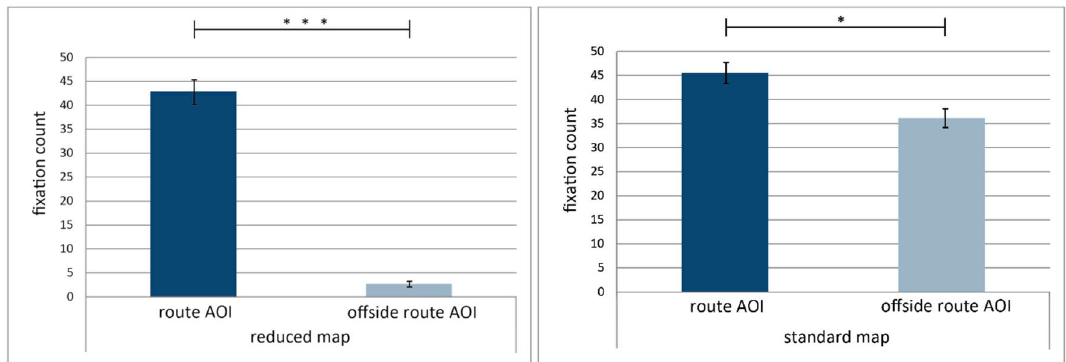
Figure 4. Fixation count differences between the route AOI and the offside route AOI for both map conditions. In both map conditions, fixation counts on the route AOI were significantly higher than fixation counts on the AOI offside the route. In the reduced maps (M RouteAOI = 42.867, M OffsideRouteAOI = 2.724, W = 1, p < 0.001), the difference was larger than in the standard maps (M RouteAOI = 45.506, M OffsideRouteAOI = 36.136, W = 88, p = .015).